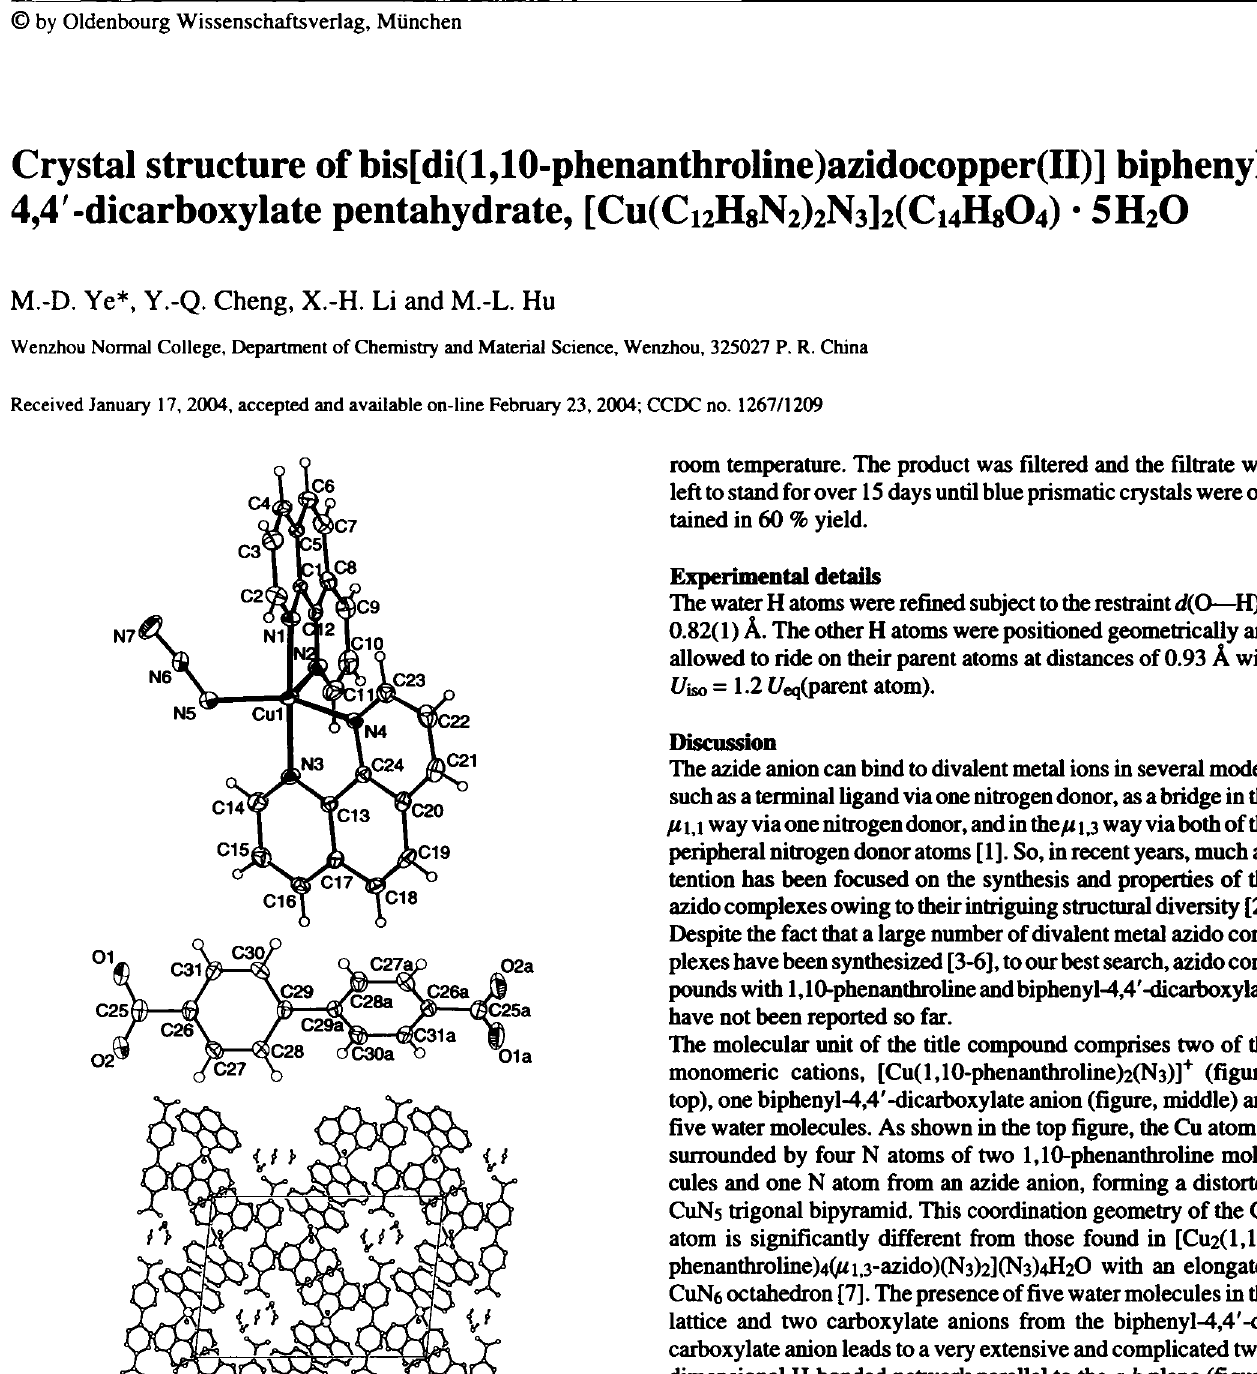
Table 1. Data collection and